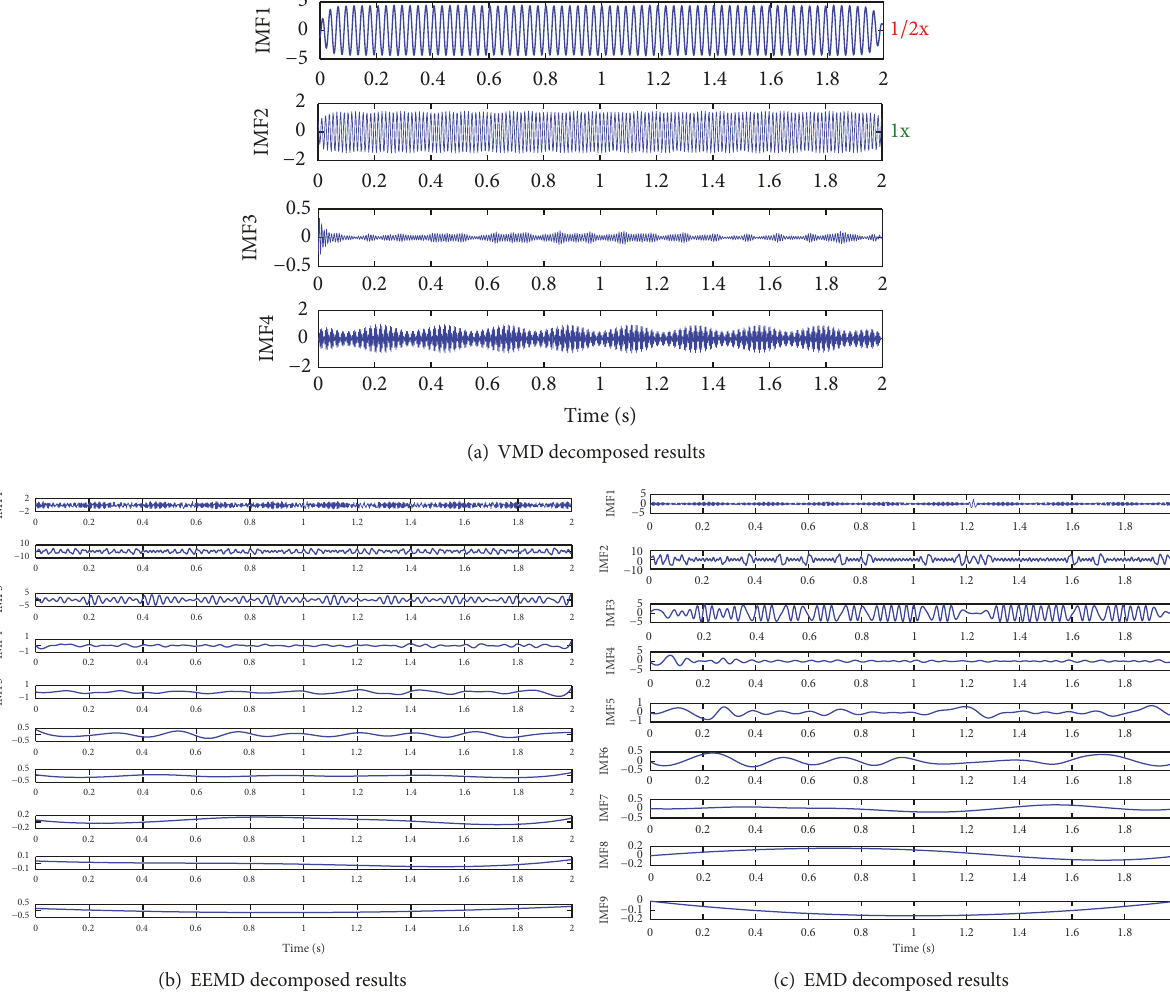
Figure 10: VMD, EEMD, and EMD decomposed results of oil whip